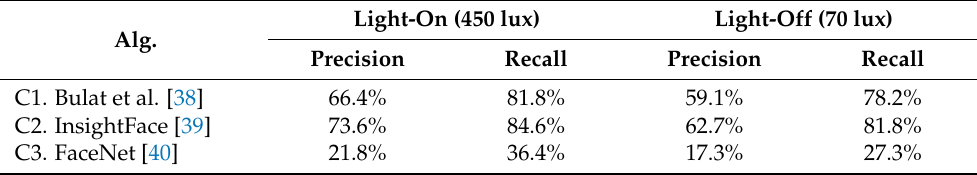
Table 3. Average computation time to process an image for the three candidates in all lighting set- tings.